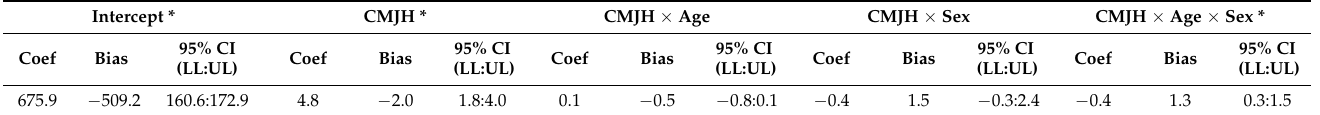
Table 4. General linear model